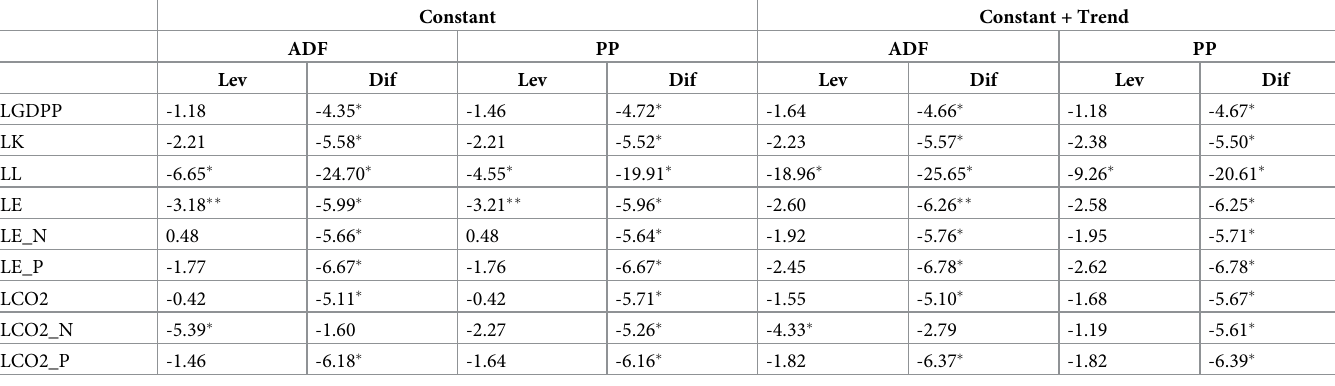
Table 2. Results of unit root